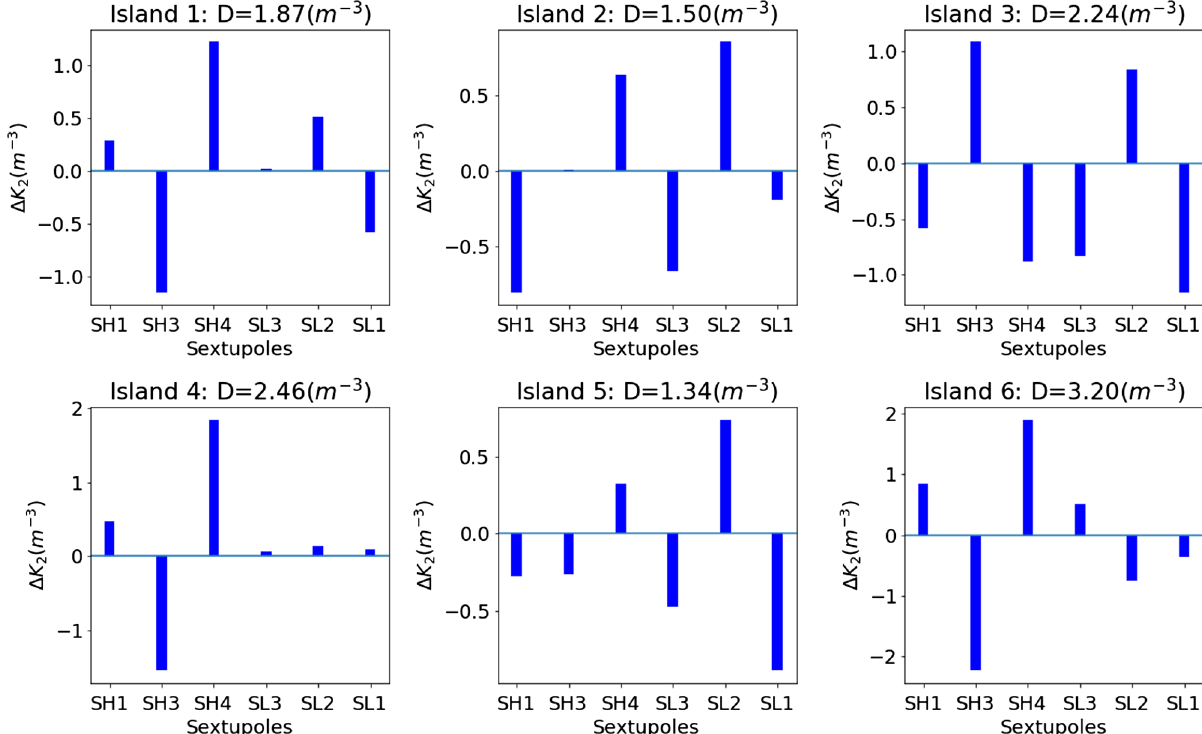
FIG. 6. Relative distances of six neighbors from one elite candidate, which is used as the reference here in the search space. The reference sextupole settings are given as K 2 ;SH 1 ¼ 26 . 20891 m − 3 , K 2 ;SH 3 ¼ − 17 . 87664 m − 3 , K 2 ;SH 4 ¼ − 6 . 39466 m − 3 , K